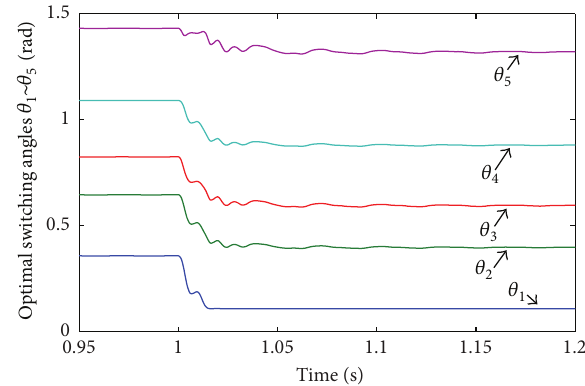
Figure 12: Three-phase load current response to load disturbance.